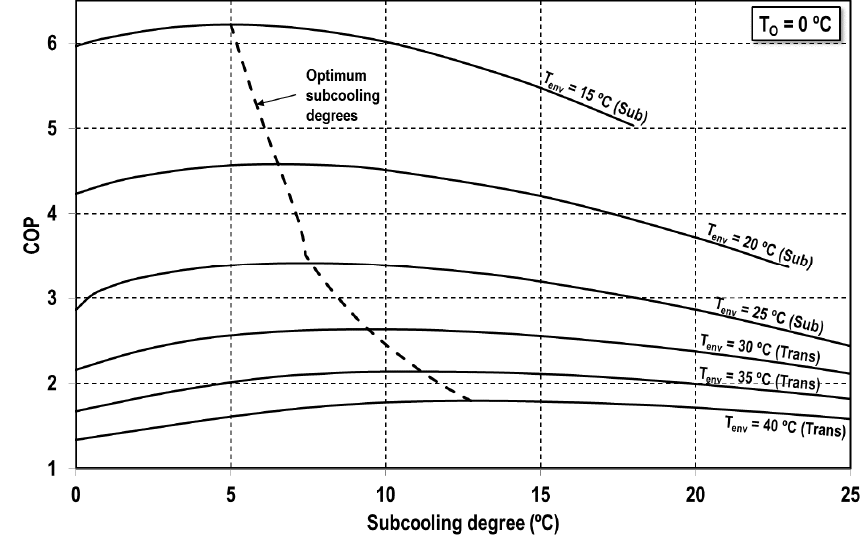
Figure 5. COP dependence on the subcooling degree of MS cycle. (T o = 0 °C).